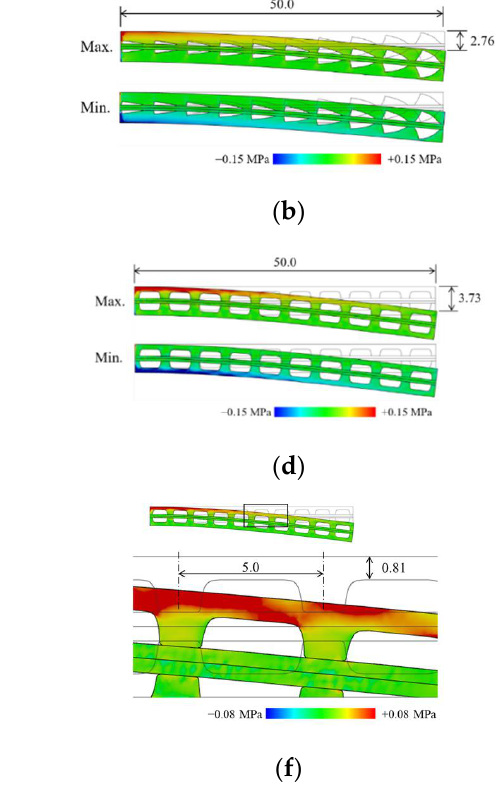
Figure 8. Maximum and minimum principal stress in a high-stiffness state in the four conditions. Homogeneous ( a ), PSL- pitch ( b ), PSL-thickness ( c ) and Pillars ( d ). Magnified images of ( c , d ) with finer stress scales are shown in ( e , f ), respectively. The load size was 0.1 N. The size of maximum vertical deflection in each condition is shown in ( a – d ).